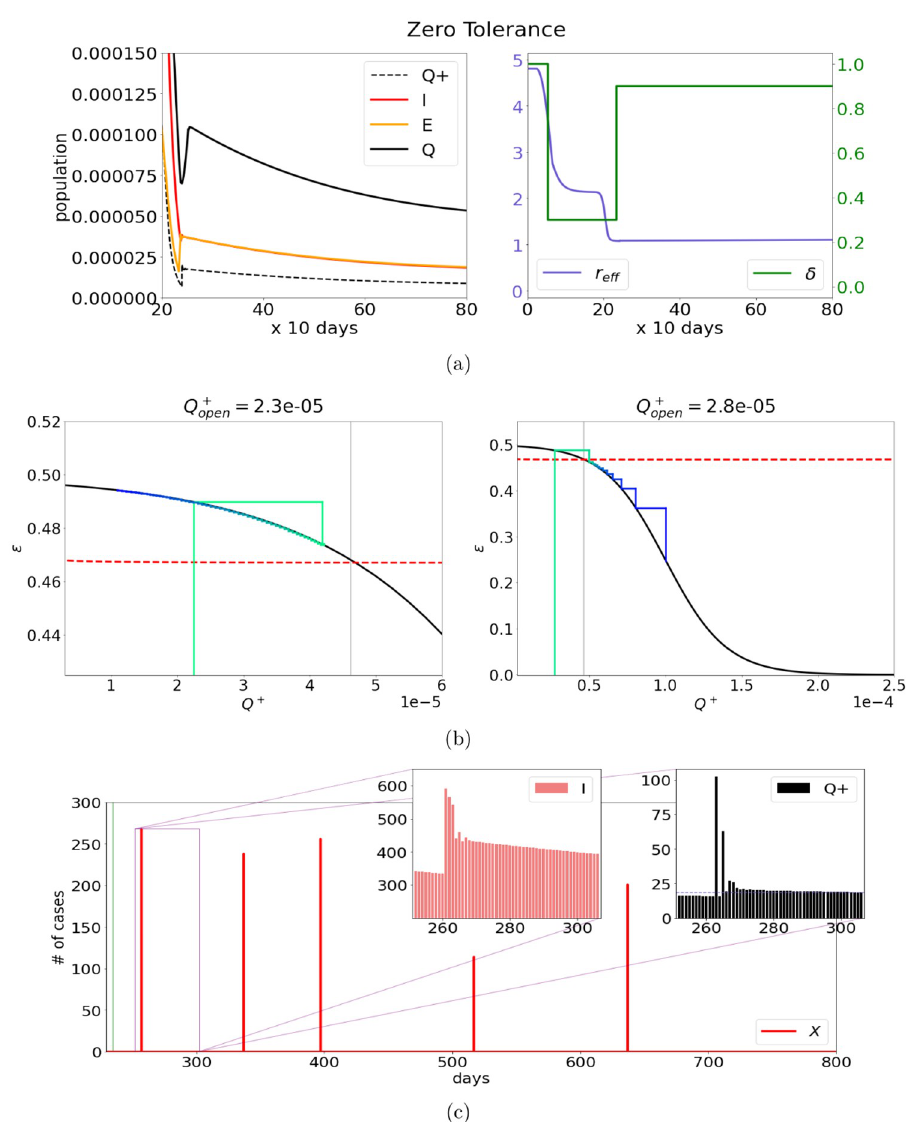
Fig 4. Zero tolerance: Instability and susceptibility to unforseen events. (a) takes a close look at the time-course of the [E]xposed and [I]nfected populations after reopening according to the Zero Tolerance strategy outlined in Model 3. After an extended lockdown brings the infection level down by several orders of magnitude, activity returns to 90% of the normal level without a drastic resurgence of infection. Plot (b) illustrates the instability of contact tracing. It shows the system’s trajectory through ( Q + , � ) space, updated every period, with time increasing as the line color changes from green to blue. The black curve is the success of contact tracing ( � ) for a given value of Q + and the red dashed line is the � required to inhibit an outbreak (numerically computed). To take advantage of contact tracing, reopening values of Q + must be to the left of the grey vertical line. That, however, may not be sufficient: an outbreak can still occur due to inevitable rise of Q + at the onset of reopening as shown in the panel on the right. Plot (c) features histograms showcasing the effect of stochastic spikes modeling events of unknown origin on I and Q + by the number of cases. The green vertical line marks the